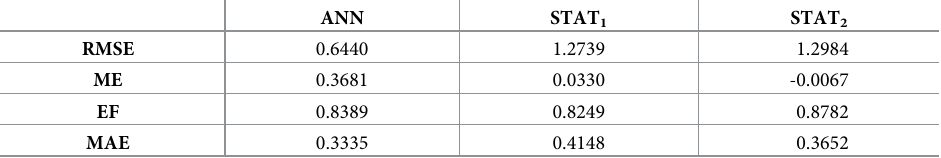
Table 6. Accuracy measurements of the artificial neural network model (ANN), the polynomial regression equa- tions (STAT 1 and STAT 2 ) for the estimation of the double bark thickness for